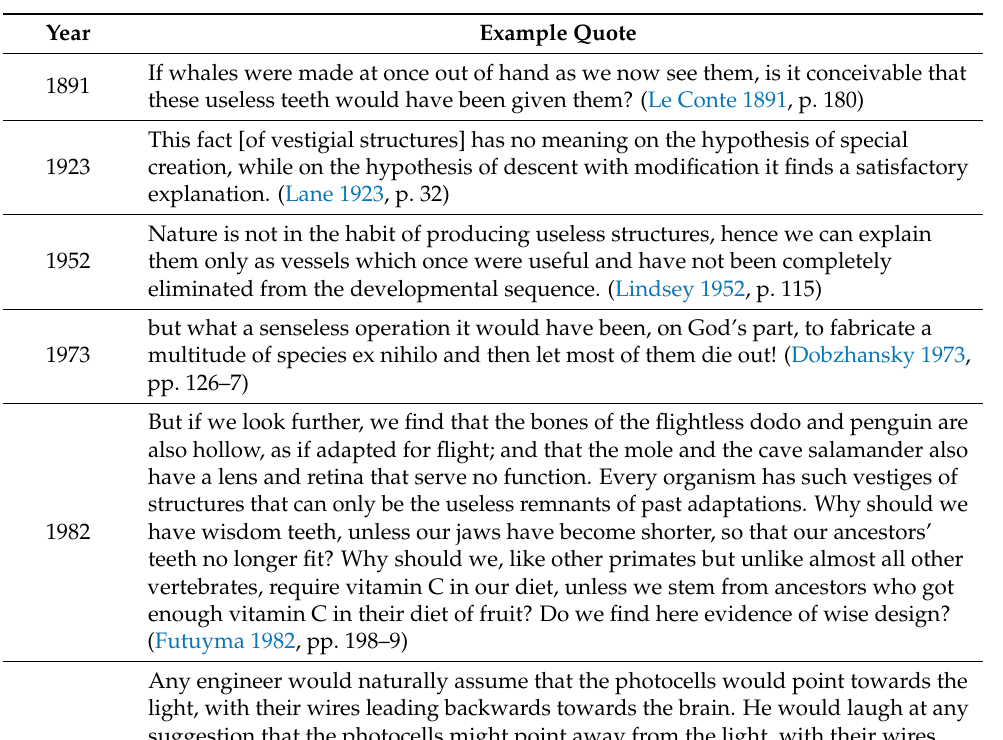
Table 2. A sampling of disutility arguments for evolution from post-Darwin